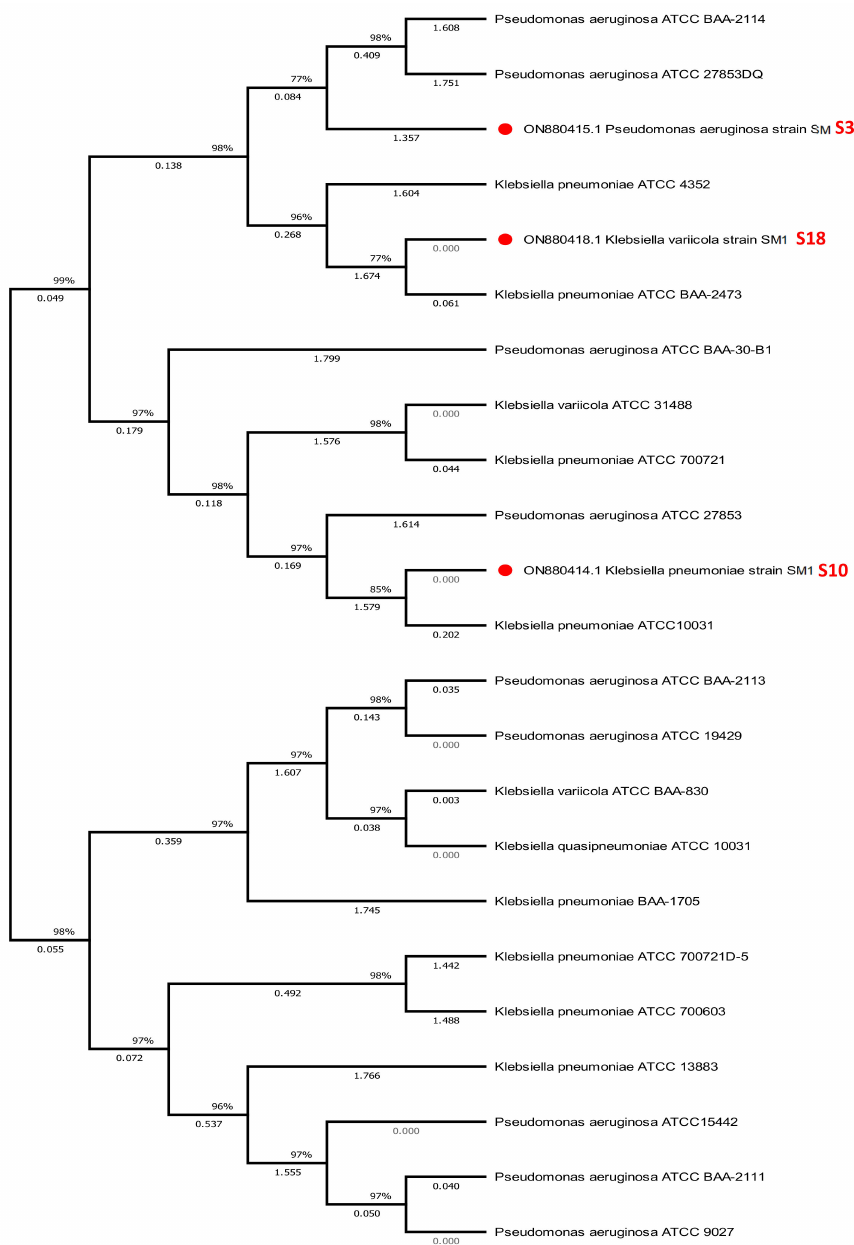
Figure 3. Phylogenetic tree of Pseudomonas aeruginosa (S3), Klebsiella pneumoniae (S10) and Klebsiella variicola